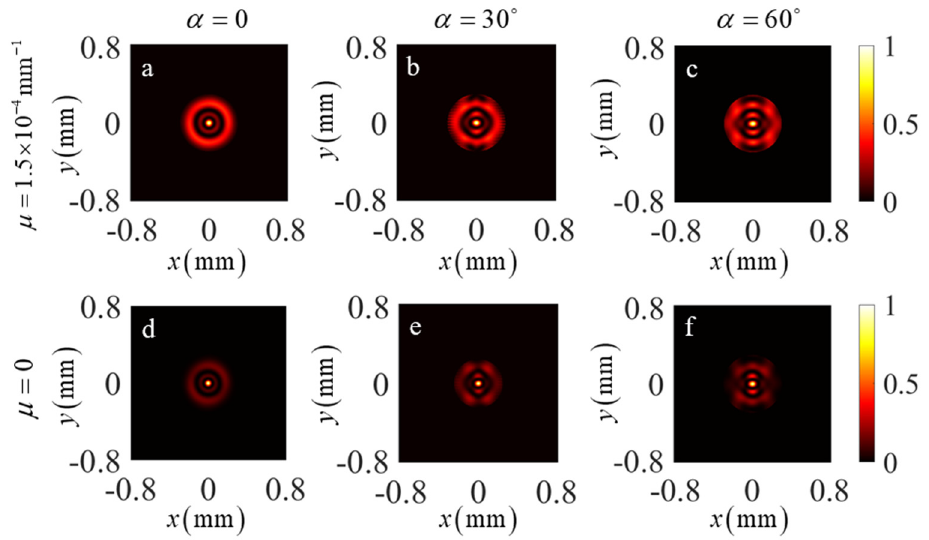
Figure 6. The simulation results for the spatial degree of coherence | γ ( ρ , − ρ ) | 2 in the focal plane of a TLGSM beam with ( a – c ) the twist factor µ = 1.5 × 10 − 4 mm − 1 and ( d – f ) µ = 0. The TLGSM beam is obstructed by a sector-shaped opaque obstacle with center angle ( a , d ) α = 0, ( b , e ) α = π /6, and ( c , f ) 𝛼 = 𝜋/3 .